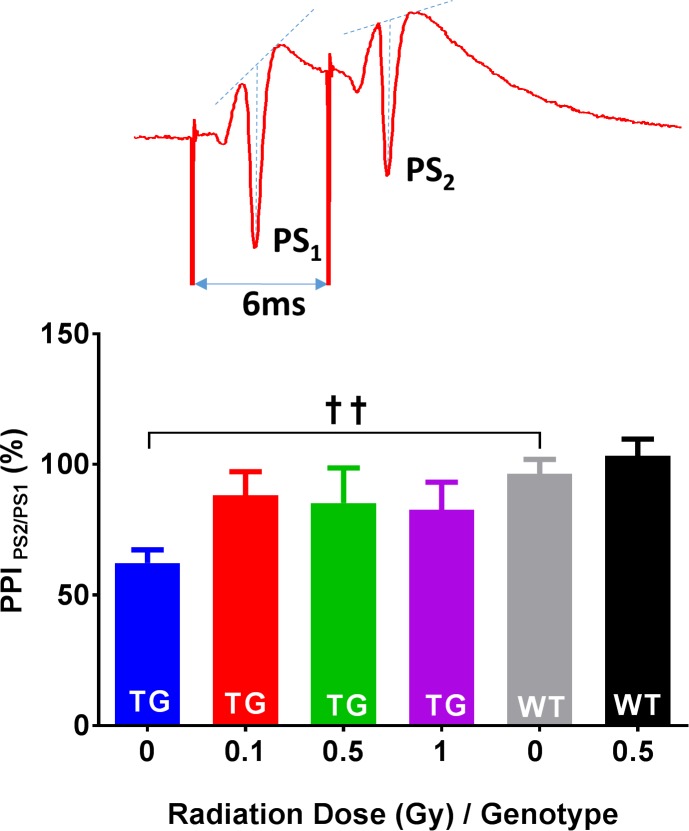
PPI in TG and WT mice 9 months post-irradiation.A comparison of PPI at 6 ms revealed stronger inhibition (~35% lower PS2/PS1 ratio) in TG control mice than in the WT control mice. Although all doses of radiation appeared to increase the PPI in TG mice, these increases were not statistically significant. Inset: Original voltage trace of PPI at 6 ms showing inhibition of the PS2 amplitude. Arrows indicate stimulation artifacts. Note that the bar graph indicates PPI values acquired at 6 ms; however, the statistical model included PPI recorded at all ISIs. TG mice: N = 12, 15, 7 and 10 slices/radiation group; WT mice: N = 16, 14 slices/radiation group. Statistical analyses: RM ANOVA, Post hoc †† p<0.01. Data represent means ± SEM.